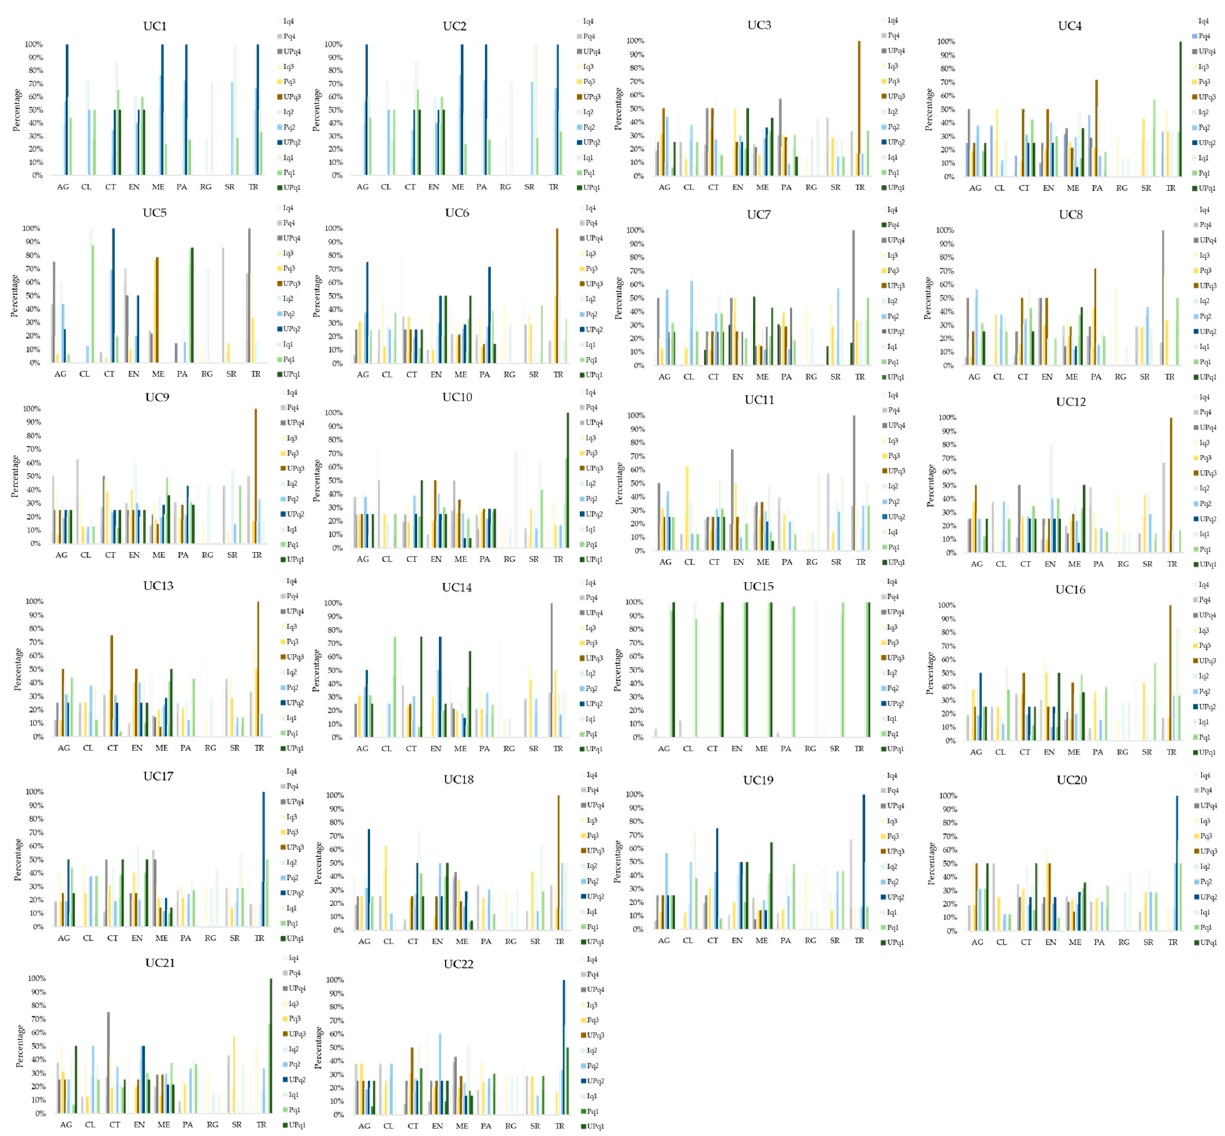
Figure A2. Comparison of the percentages of municipalities for different metropolitan cities in Sicily based on the quartiles of indicators for urban capital, and the NSIA classification. (Authors’ elabo- ration.)